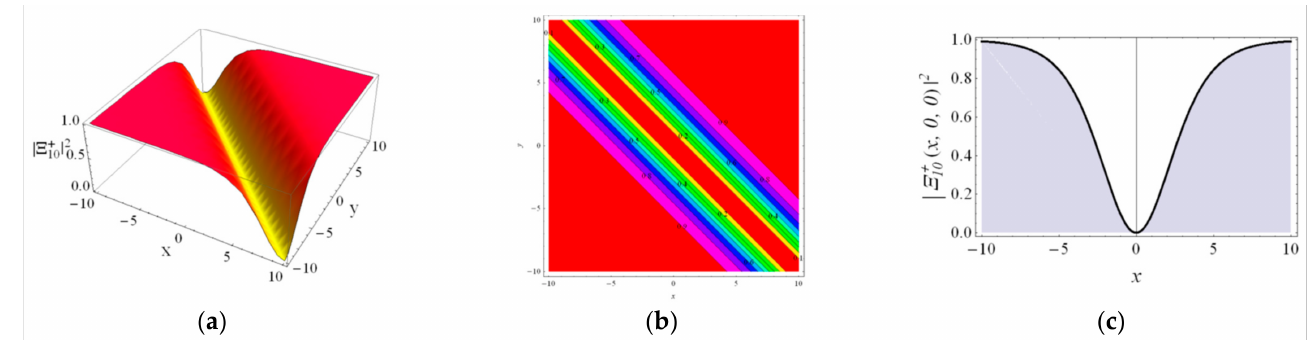
(cid:12) (cid:12) 2 with the parameters ε (cid:12) Ξ + (cid:12) 10